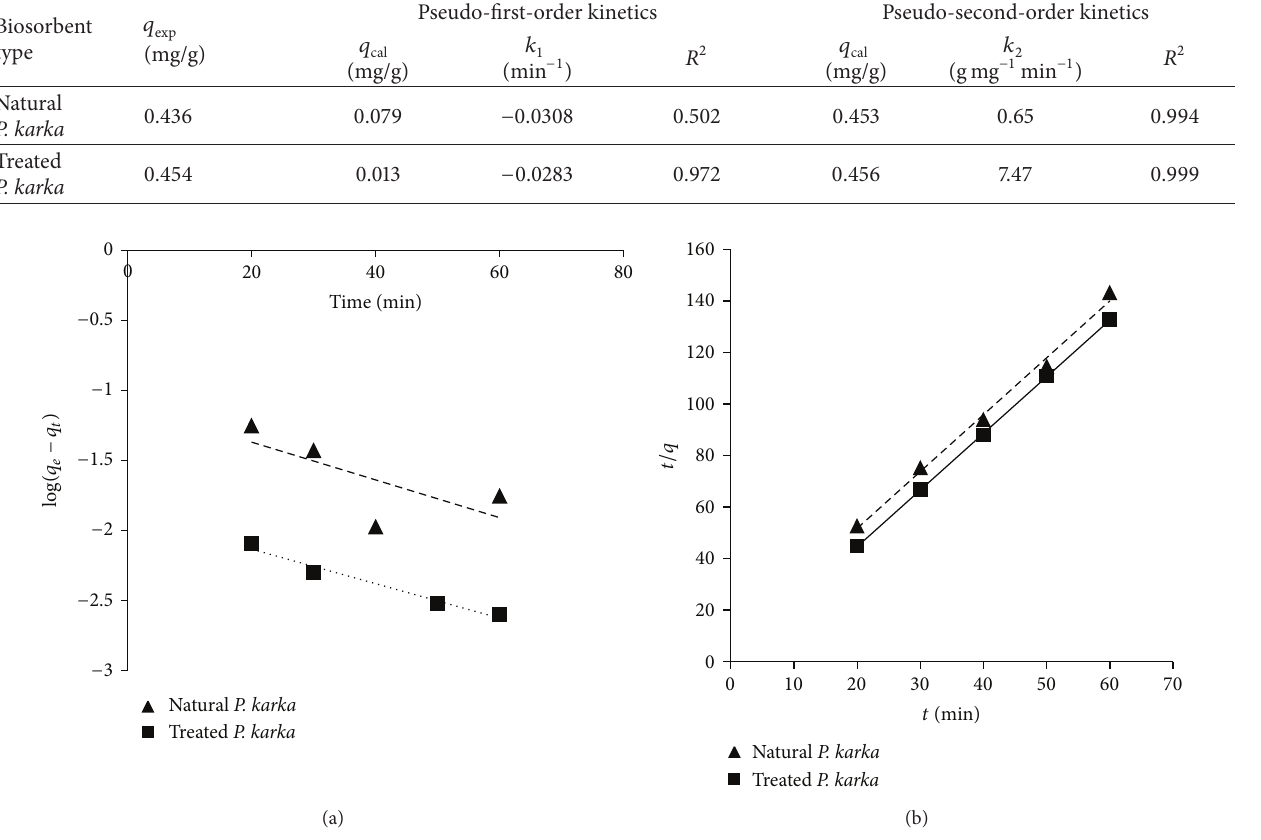
Figure 7: (a) Pseudo-first-order rate kinetics of Hg(II) for natural P. karka and treated P. karka . (b) Pseudo-second-order rate kinetics of Hg(II) for natural P. karka and treated P. karka (concentration = 10 mg/L, time = 20–60 minutes, 𝑇 = 298 K, agitation speed = 150 and 100rpm natural P. karka and treated p. karka , resp., dose of biosorbent = 1g/100mL, and pH = 6 and 7 for natural P. karka and treated p. karka ,